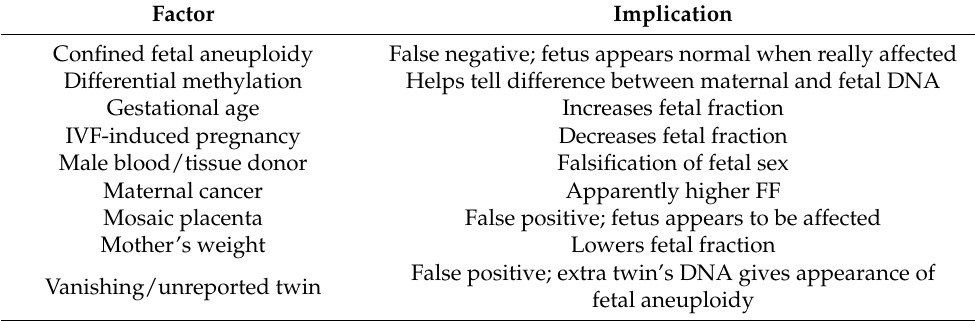
Table 2. Factors influencing the FF.